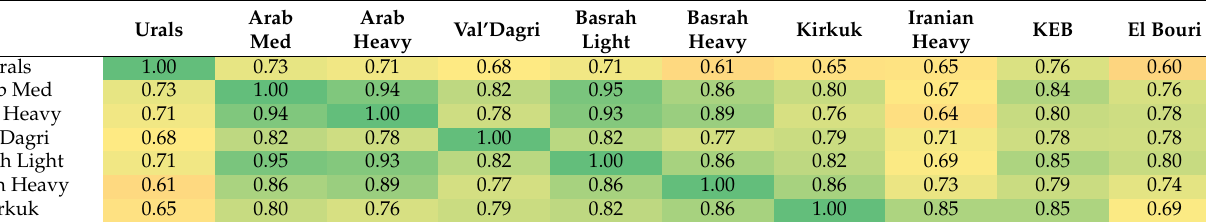
Table 9. The µ -values of the ICrA evaluation of similarities between the individual SRVR s and individual H-Oil